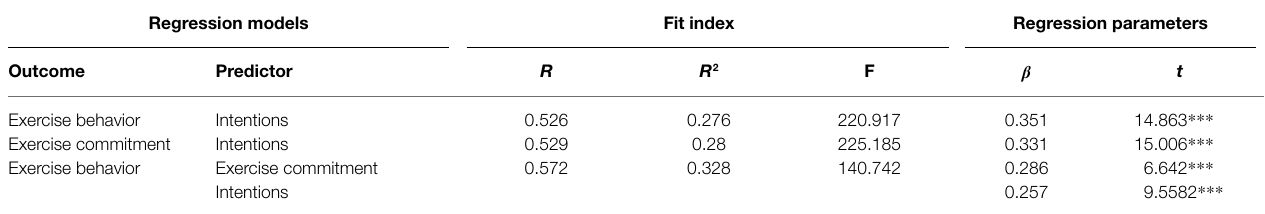
TABLE 2 | Regression analyses for testing the mediation effect of exercise commitment. Regression models